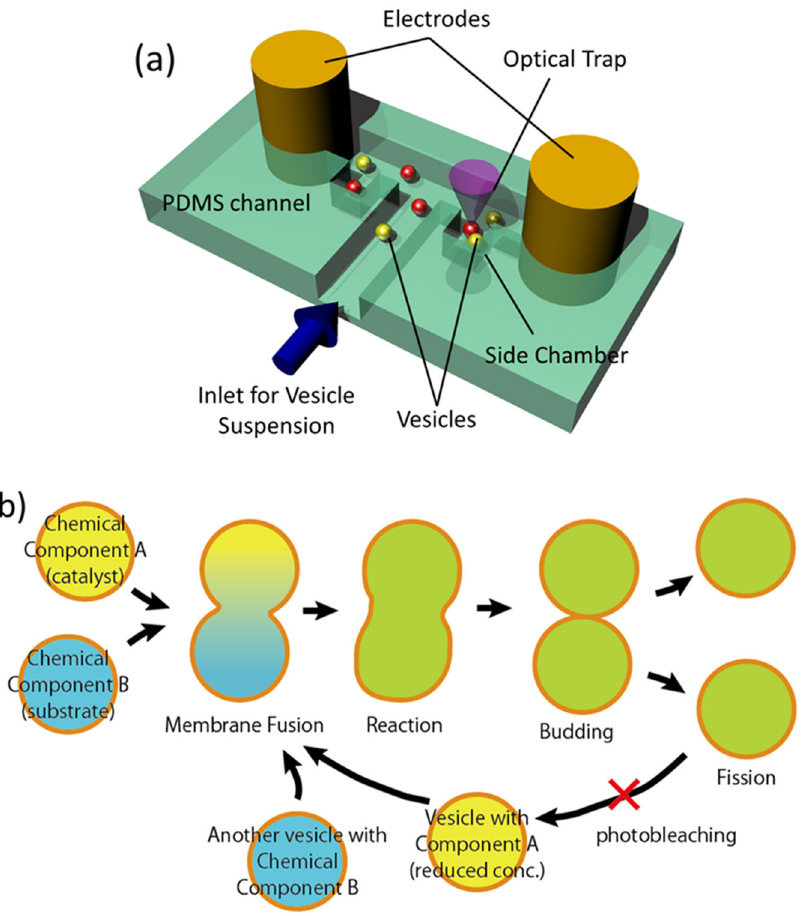
Figure 1. (a) Overview of the experimental setup. Giant vesicles are manipulated with optical tweezers and fused with an electrical pulse. (b) Schematic of the chemical-handling processes using GUVs. Reagent mixing is induced by fusion, and the reaction products are aliquoted by vesicle division. These processes are repeated for sequential (bio)chemical reactions. In the following experiments, reactions that fluoresce upon reagent mixing are used. The fluorescence in the GUV resulting from the first fusion and reaction is photobleached before the second